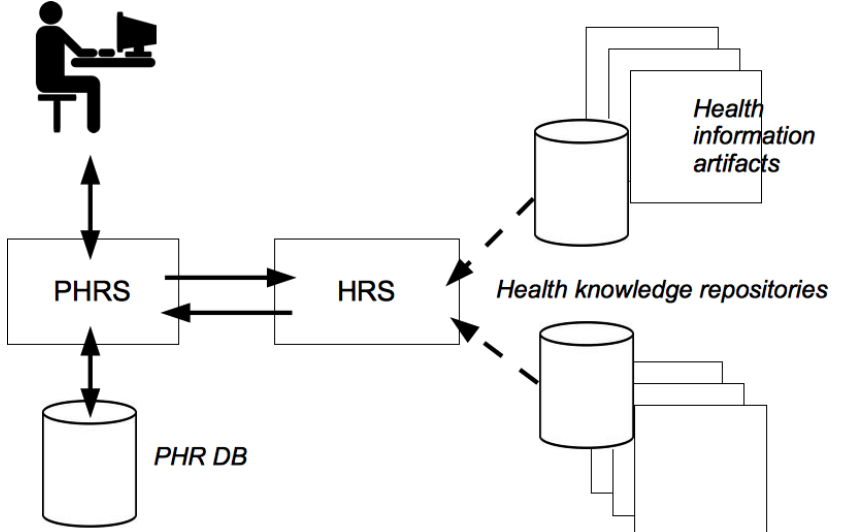
Figure 1. System context of an HRS-enabled PHR